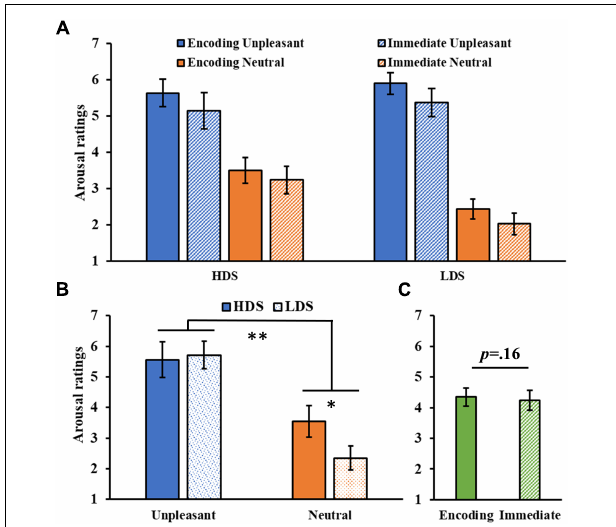
FIGURE 4 | (A) Valence ratings as a function of the group and of the category of stimuli (unpleasant and neutral pictures) at the encoding and at the delayed recognition sessions. (B) Session (encoding and delayed recognition sessions) × Category (unpleasant and neutral pictures) interaction for the valence ratings. (C) Group (HDS and LDS) main effect for valence ratings. LDS: participants with lower depression symptoms; HDS: participants with higher depression symptoms. Error bars represent standard error of the mean. ∗ p < 0.05; ∗∗∗ p <